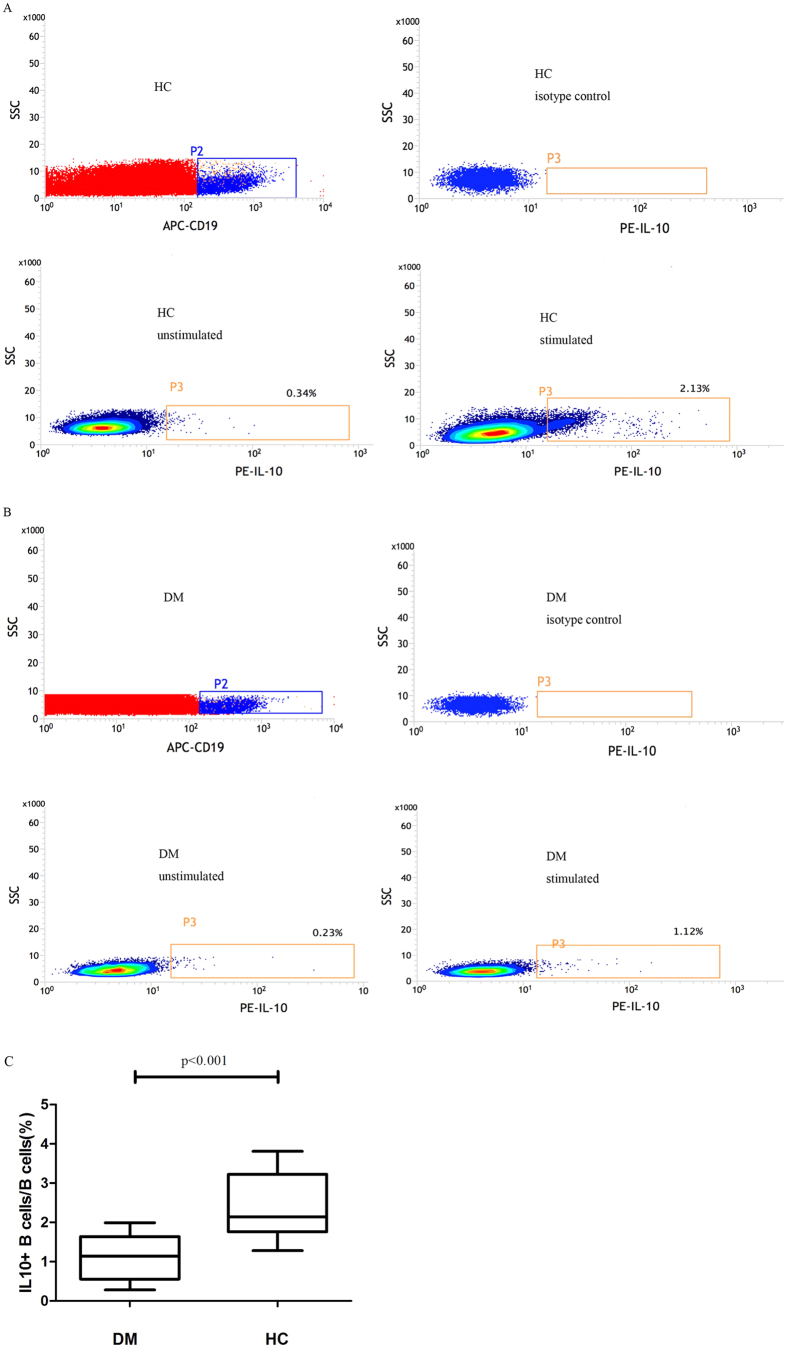
Analysis of intracellular IL-10 production.(A,B) Representative B cell cytoplasmic IL-10 expression in healthy individuals (A) and in DM patients (B) after 6 hours of in vitro stimulation with Leukocyte Activation Cocktail, surface staining with APC-labeled anti-CD19, and intracellular staining with PE-labeled anti–IL-10. (C) the frequency of IL-10+ B cells was significantly lower in DM patients than in healthy controls (1.139 ± 0.156% vs 2.372 ± 0.205%, p < 0.001).